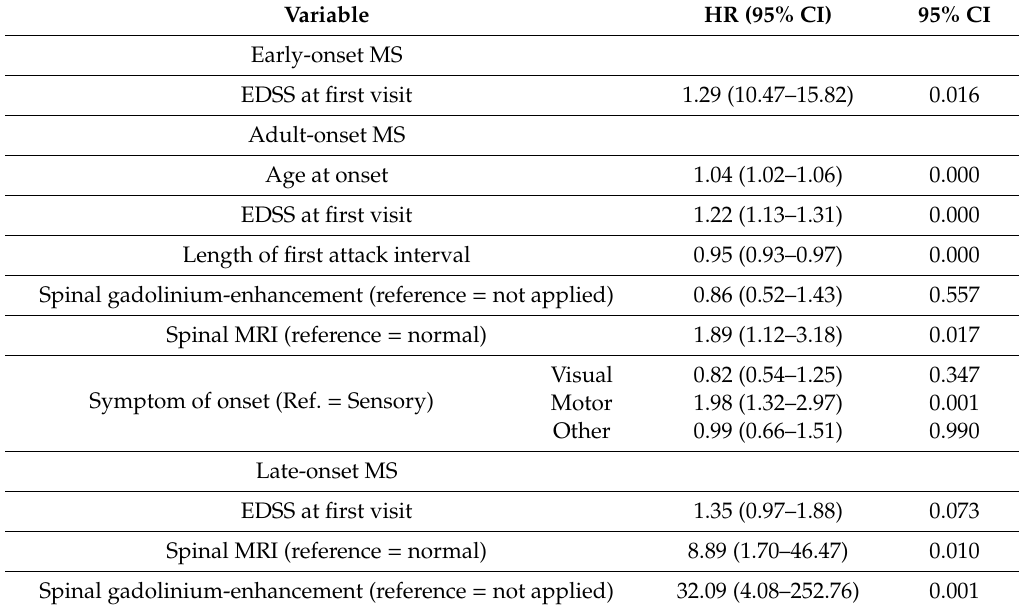
Table 5. Multivariate cox regression model to predict secondary progressive MS conversion in the